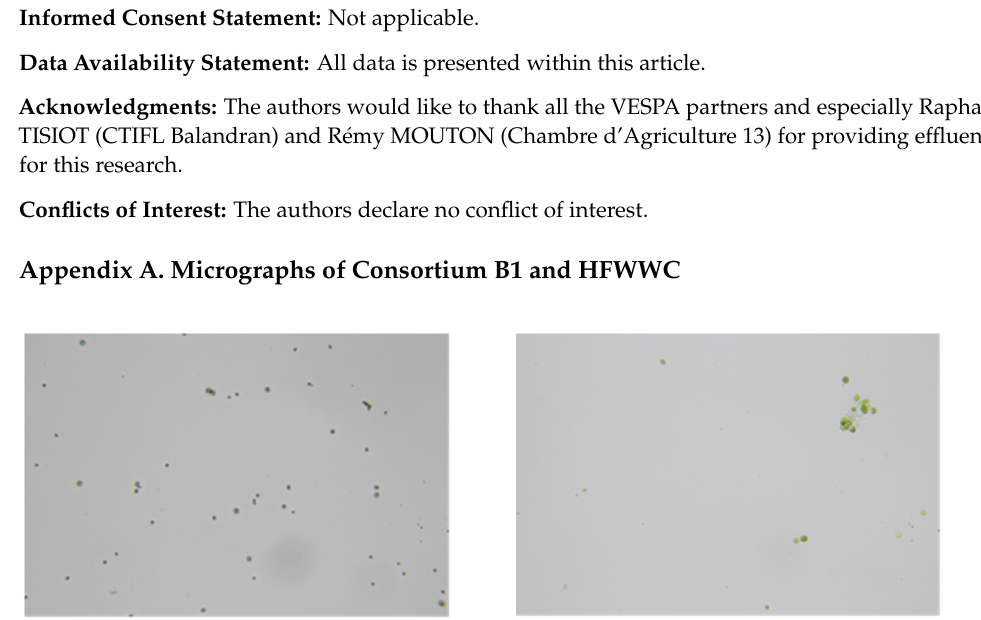
Figure A1. Micrographs x200 of consortium B1 ( left ) and HFWWC ( right ).